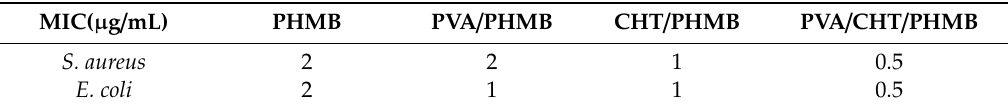
Table 1. The data of MIC